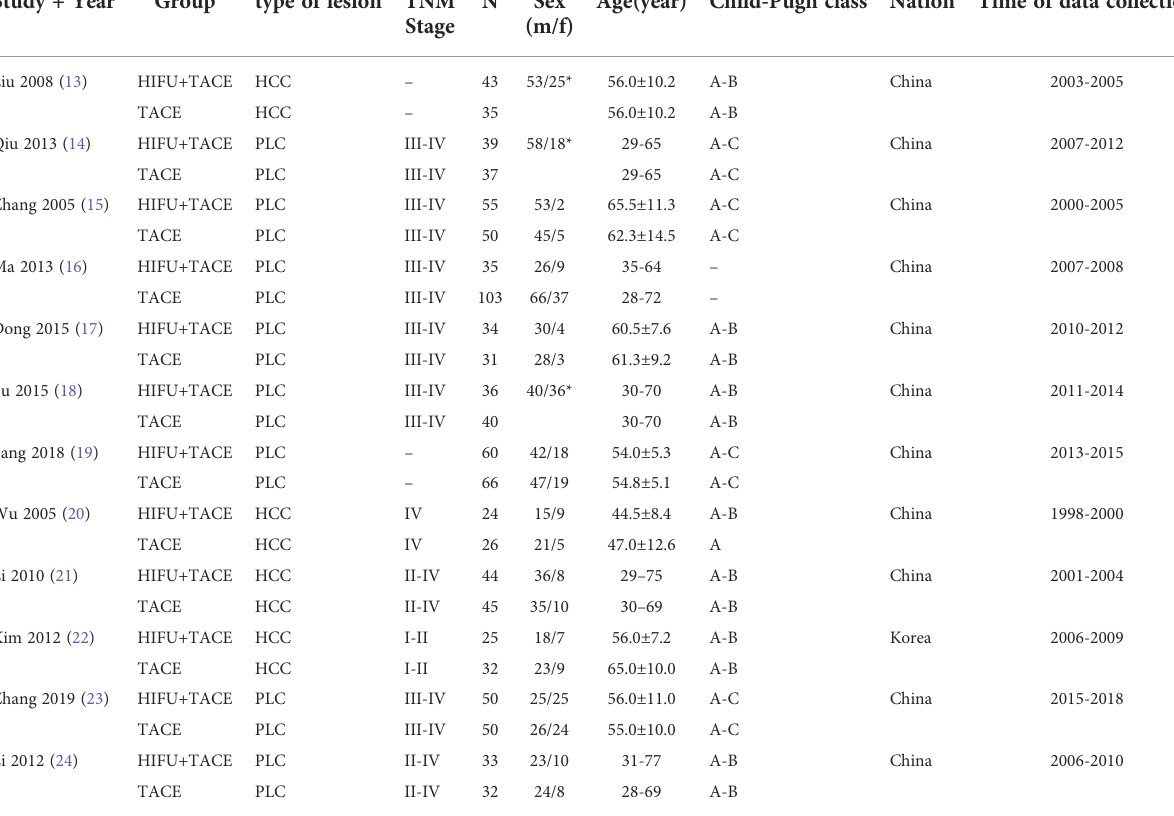
TABLE 1 Basic information of the included